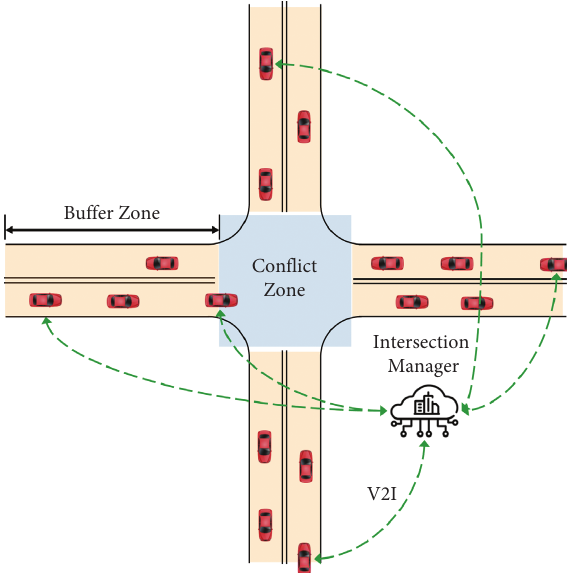
Figure 1: An exemplar scenario of CIM at a four-armed